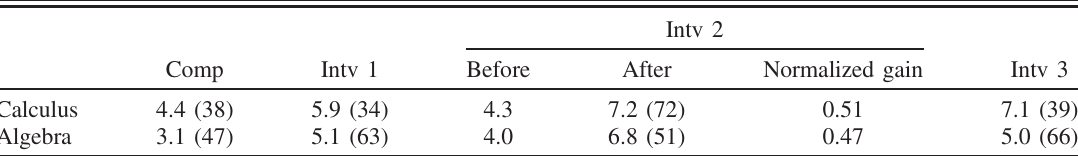
TABLE III. Students ’ average scores for magnitude of friction (out of 10 points) in the calculus-based and algebra- based courses. The numbers of students in the comparison (Comp) group and each of the three intervention (Intv) groups are shown in parentheses. In the intervention group 2, students ’ performance both before and after they received the scaffolding was examined and the average normalized gain a was calculated.